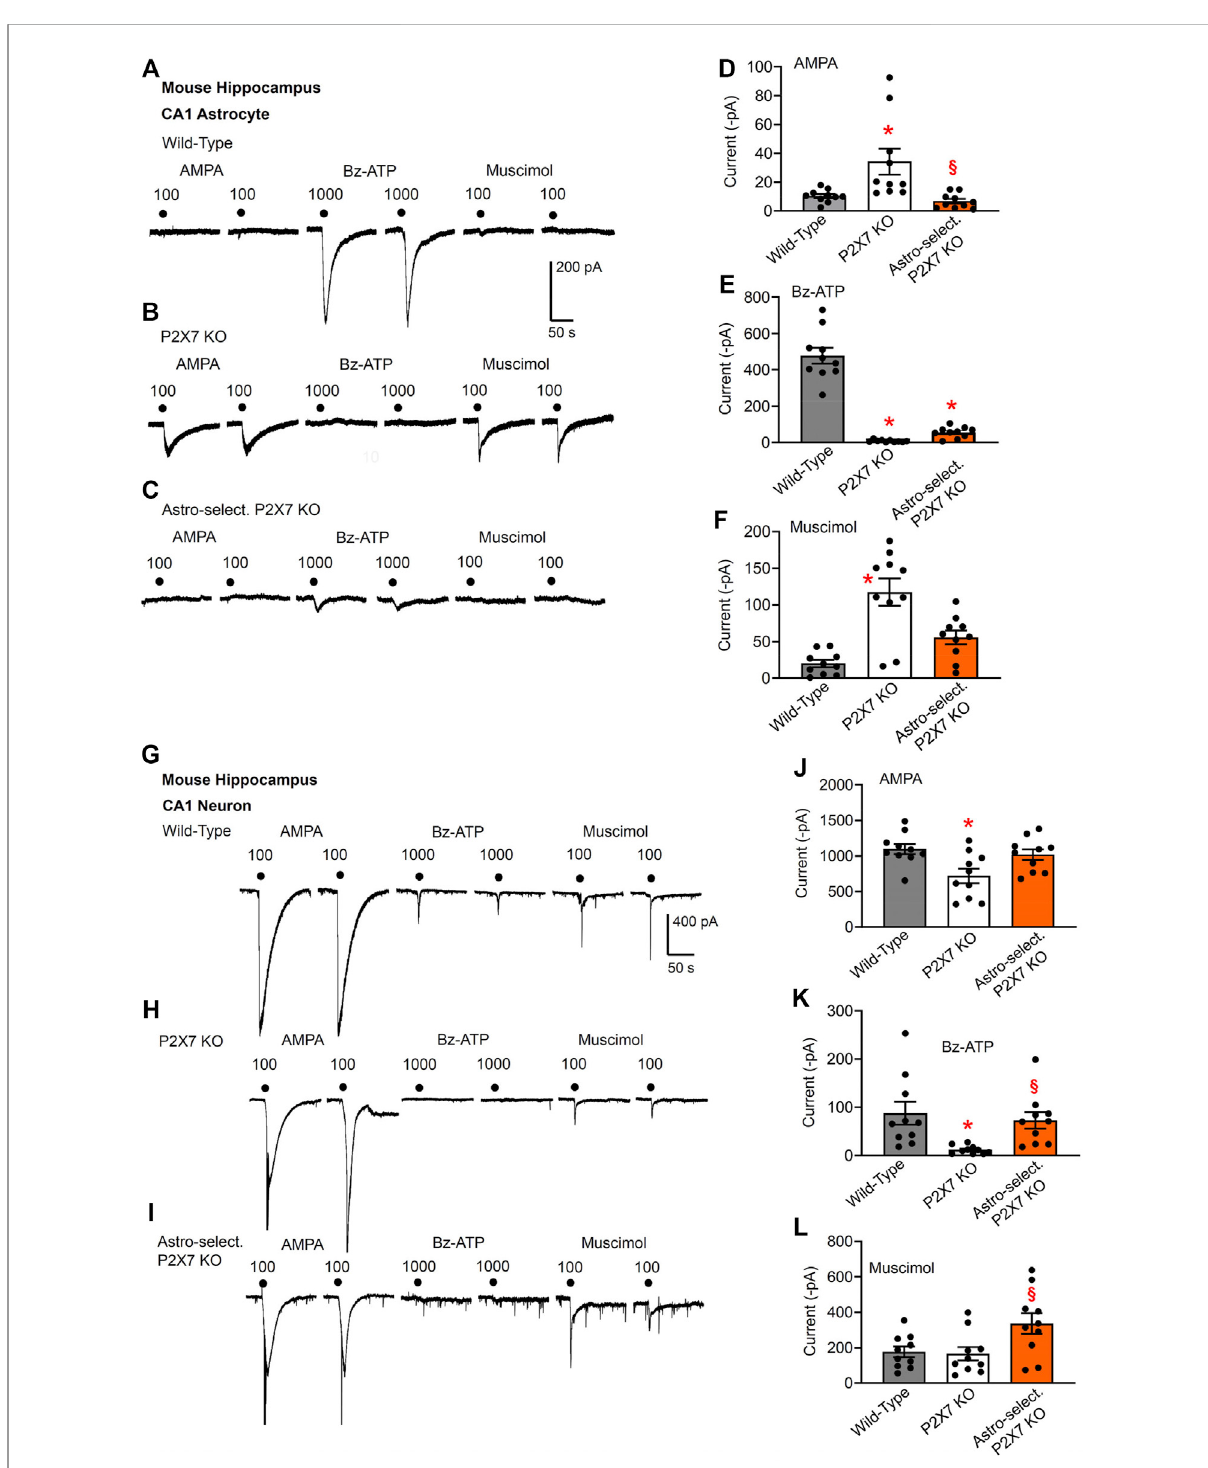
FIGURE 1 CurrentresponsestoionotropicreceptoragonistsintheCA1areaofthemousehippocampus.Hippocampalbrainslicesof10 – 15 day-oldwild- type (WT) mice, as well as mice whose P2X7Rs were genetically deleted either in all cells, or selectively in astrocytes. AMPA (100 µM), Bz-ATP (1,000 µM)and muscimol(100 µM)were locally applied every 3 min, each agonisttwice. (A – F) The membranecurrents wererecordedin astrocytes by means of the whole-cell patch-clamp method at a holding potential of − 80 mV. The superfusion medium was in this and all further experimentsalowX 2+ -containingaCSFsolution(seeMethods).Representativetracingsin (A – C) .EffectsofAMPA (D) ,Bz-ATP (E) ,andmuscimol (F) in